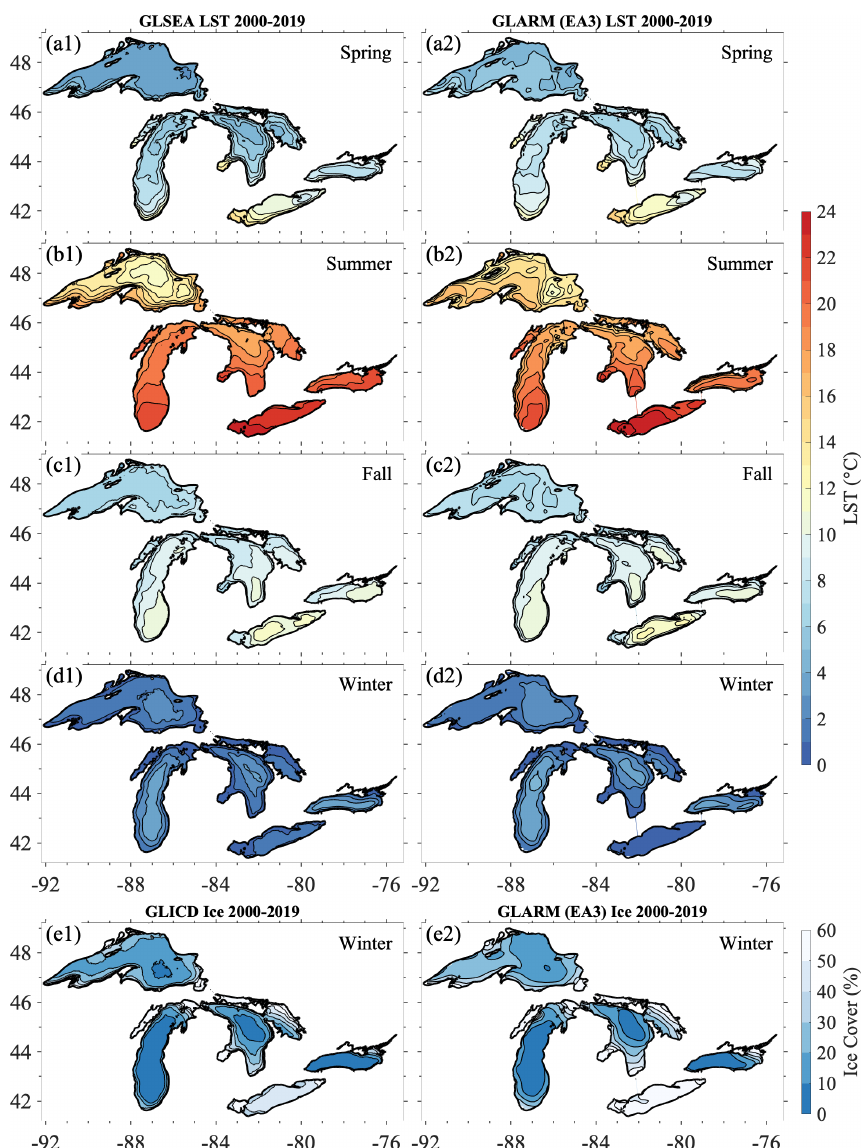
Figure 4. LST seasonal climatologies (2000–2019) during (a1, a2) spring (April–June, AMJ), (b1, b2) summer (July–September, JAS), (c1, c2) fall (October–December, OND), and (d1, d2) winter (January–March, JFM), and the winter ice cover climatologies (e1, e2) . The winter LSTs are the average for the whole lakes (including regions with snow, ice, and open water). The GLSEA LST and GLICD ice cover are shown on the left panels; the GLARM-EA3 simulations are shown on the right